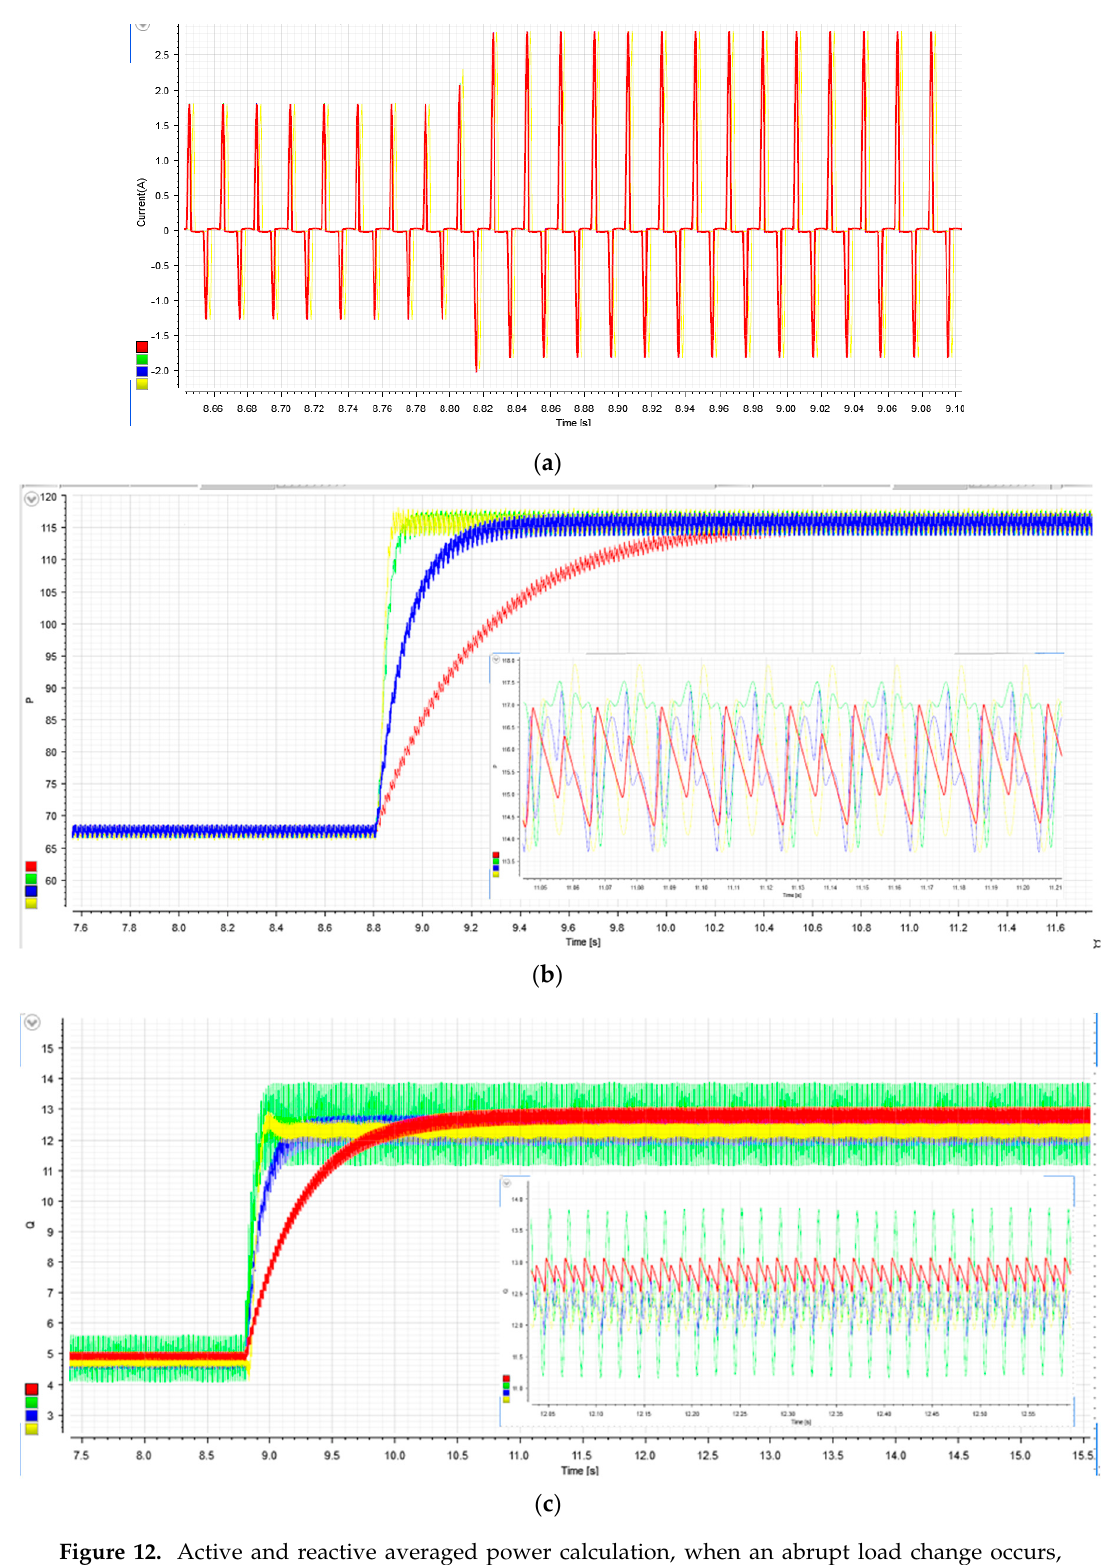
Figure 12. Active and reactive averaged power calculation, when an abrupt load change occurs, through HIL emulation employing a dSPACE-RTI setup at Aalborg Microgrid Laboratory: ( a ) NLL current; ( b ) active power calculation, Pav (yellow), PavM (green), PavT (blue), PavC (red), and their steady-state ripple detail; ( c ) reactive power calculation and its steady-state ripple detail; Qav (yellow), QavM (green), QavT (blue), and QavC (red). Figure 12a corresponds to the current in the asymmetric NLL, with peaks of +2.85A and − 1.8A after the load step.